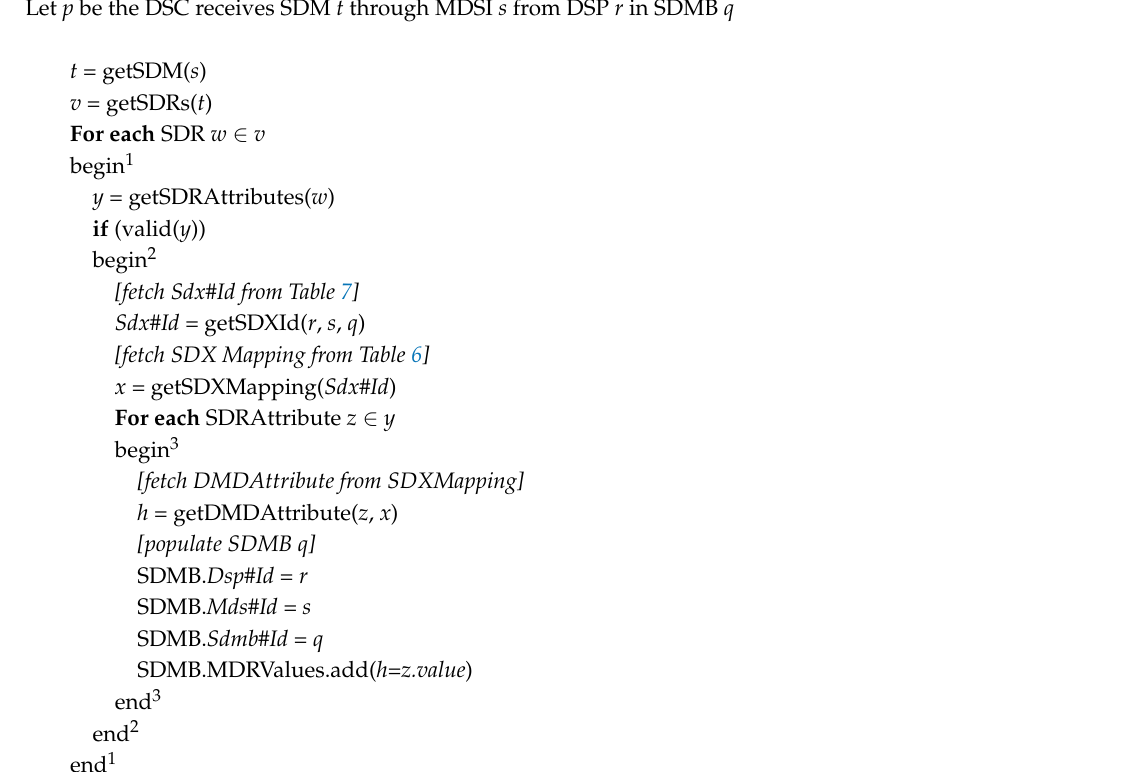
Algorithm 4. Validation, Transformation and Population of